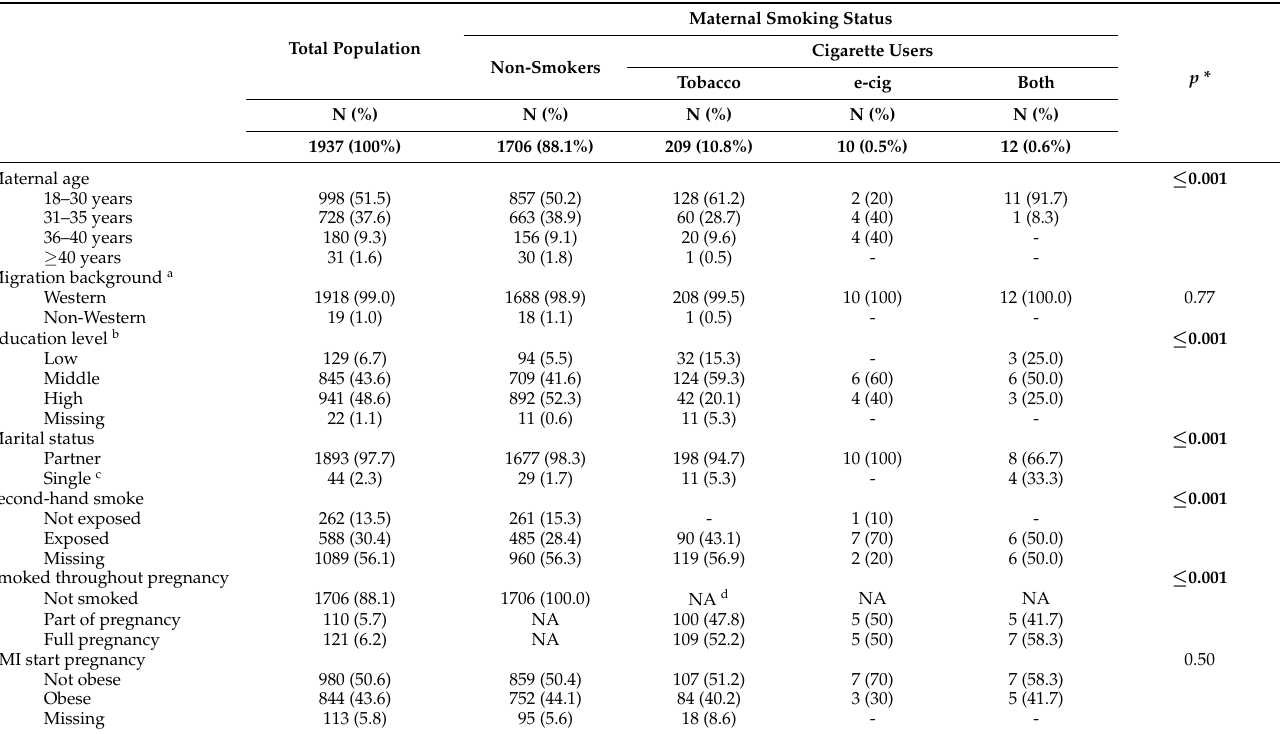
Table 1. Demographic and lifestyle characteristics by smoking status (N =